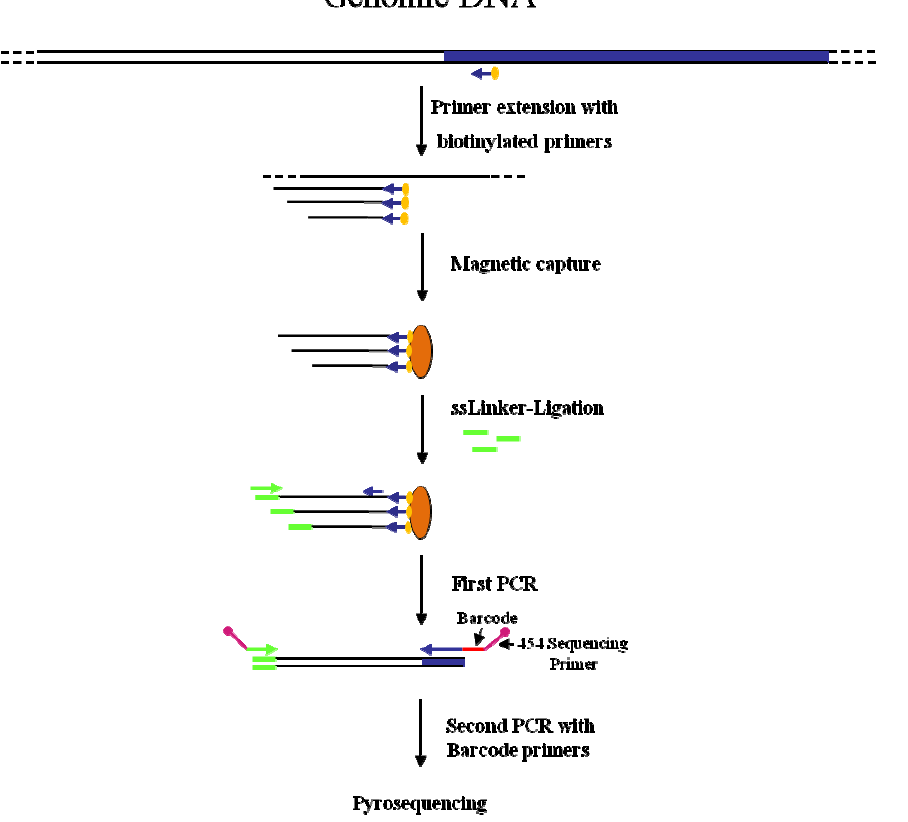
Figure 2. Main steps of nrLAM-PCR GW and pyrosequencing association strategy. Blue and white bars correspond to known and unknown sequences, respectively. A blue arrow with a small yellow oval corresponds to biotinylated primers in the known nucleotide region. An orange oval indicates a streptavidin magnetic device. Green and blue arrows represent primers designed in correspondence of the linker and known genomic region, respectively. Barcodes and 454 sequencing traits of longer amplification primers are indicated in the